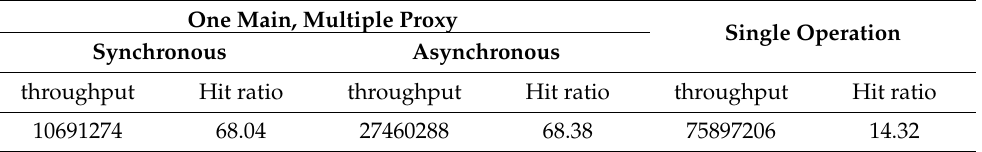
Table 1. Performance comparison of the three versions of synchronization methods. The three meth- ods are the one-main multi-proxy real-time synchronization method, the one-master multi-agent asyn- chronous synchronization method, and the method where each operation is synchronized